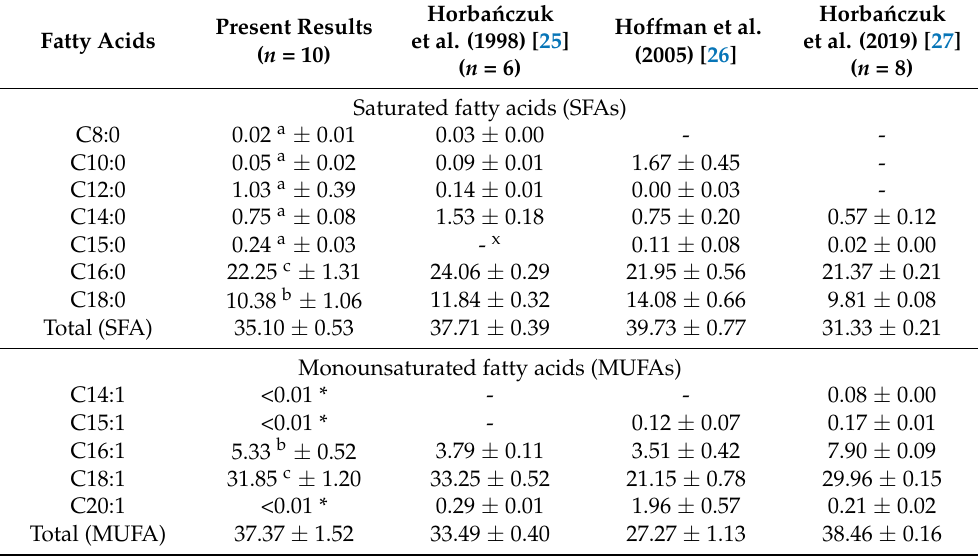
Table 6. Fatty acid composition (%) in the estimated total sum of fatty acid of ostrich outside strip and that of several